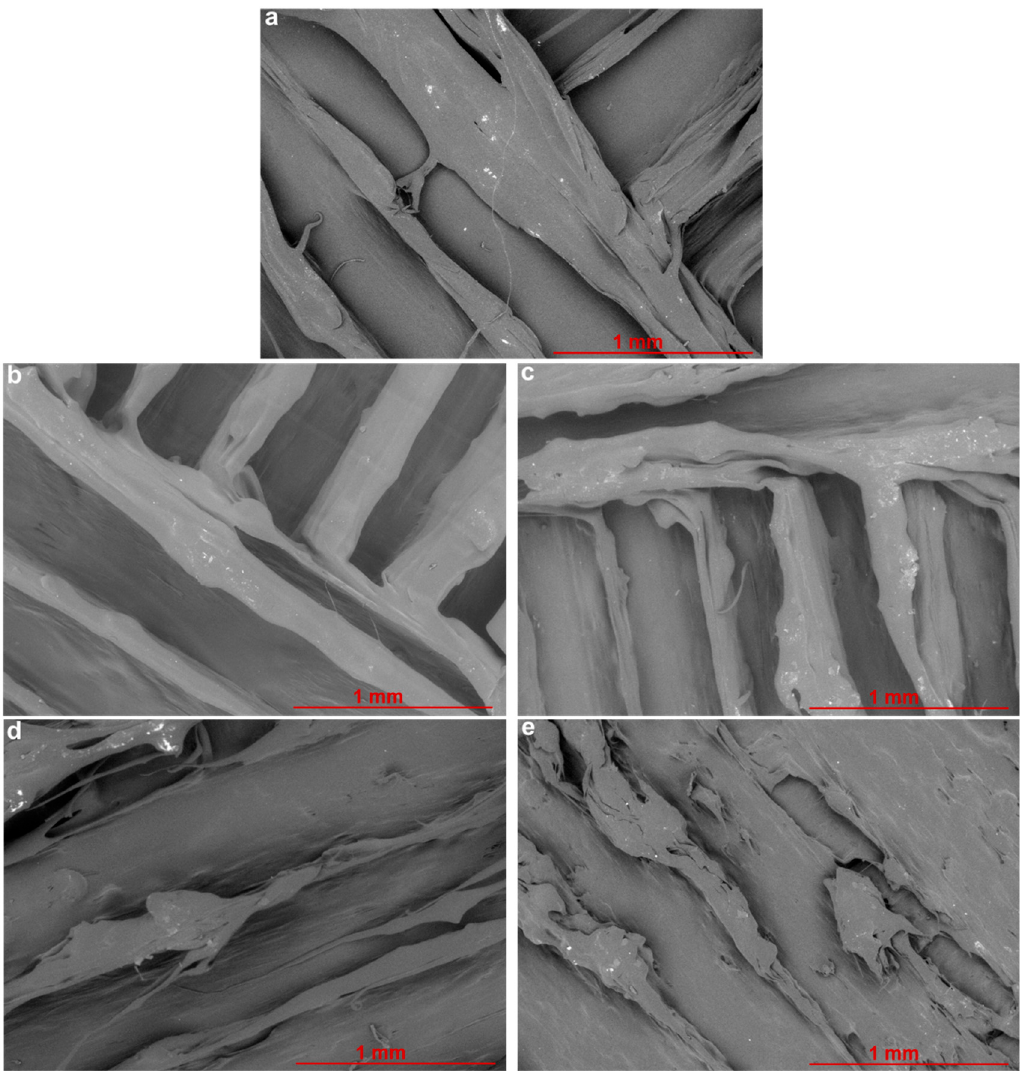
Figure 1. FESEM images from one random location on the upper surface of 3D-fabricated scaffolds, ( a ) PCL, ( b ) PCL+0.75G, ( c ) PCL+1.5G, ( d ) PCL+3G, and ( e ) PCL+6G, at 50× magnification. SEM images were acquired at an acceleration voltage of 5 kV, under a low vacuum of 60 Pa combined with the backscattered electron detector, using a nominal spot size of 30 nm. Scale bar represents a 1 mm distance within the image.